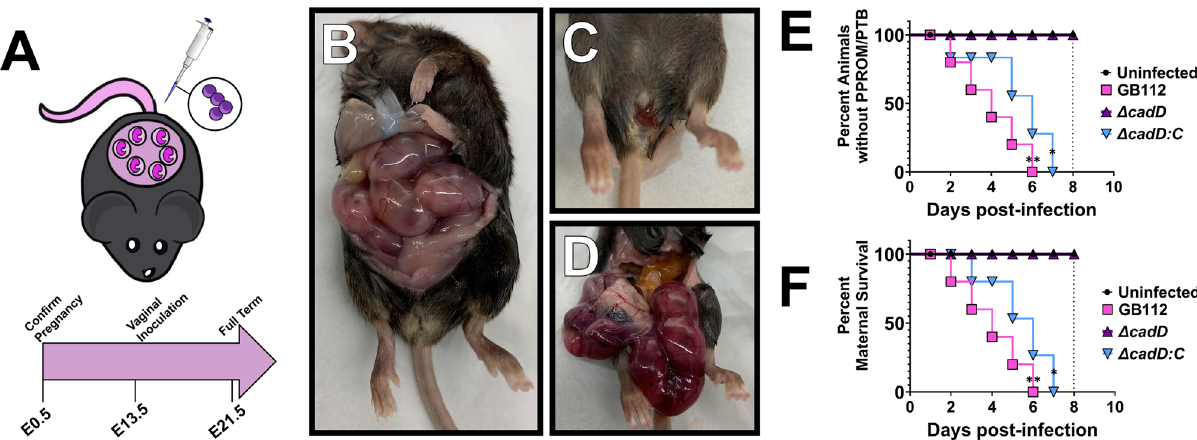
Fig. 4 | CadD contributes to GBS pathogenesis and cognate disease outcomes associatedwithinfection.A Experimentaldesign.Animalswereharemmatedand pregnancy was con fi rmed at embryonic day 0.5 by the presence of a mucus plug (E0.5).Atembryonicday 13.5(E13.5)animalswereinfected intravaginally withGBS. B Healthy pregnancy at 2 days post-infection vs. C premature rupture of mem- branes (PPROM) and D intrauterine hemorrhage at 2 days post-infection as a consequence of GBS infection. Analyses of percent animals E without PPROM or preterm birth (PTB) or F maternal survival. Dotted line indicates term for the averagegestationintheC57BL6/Jmousemodelusedinthisstudy. n =12animalsin the uninfected control group and 15 animals in the experimental groups.